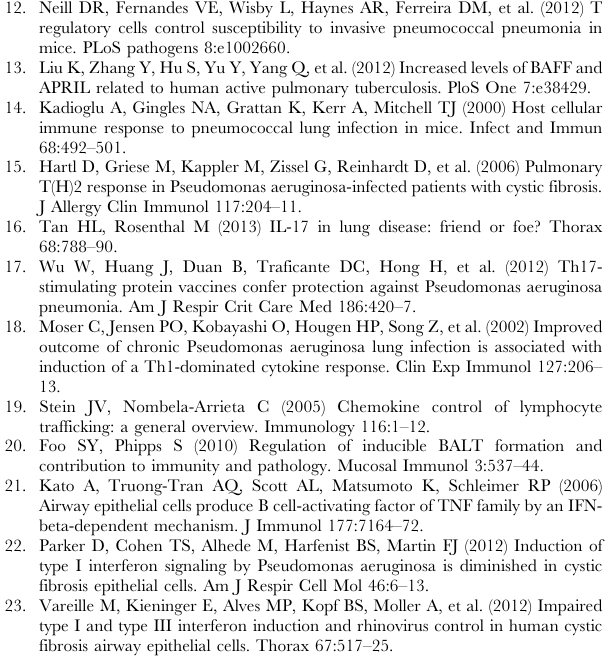
Table S1 Additional Bacteria identified in patient BAL samples and respective P. aeruginosa status for each patient.